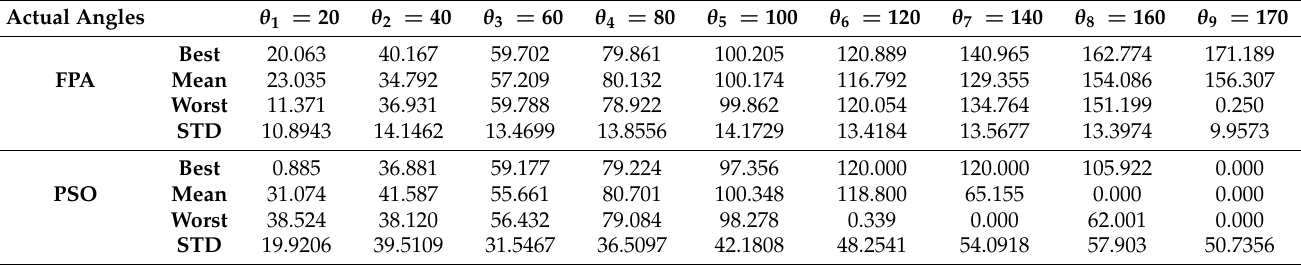
Table 5. Estimation accuracy and STD for nine targets at SNR = − 5 dB.